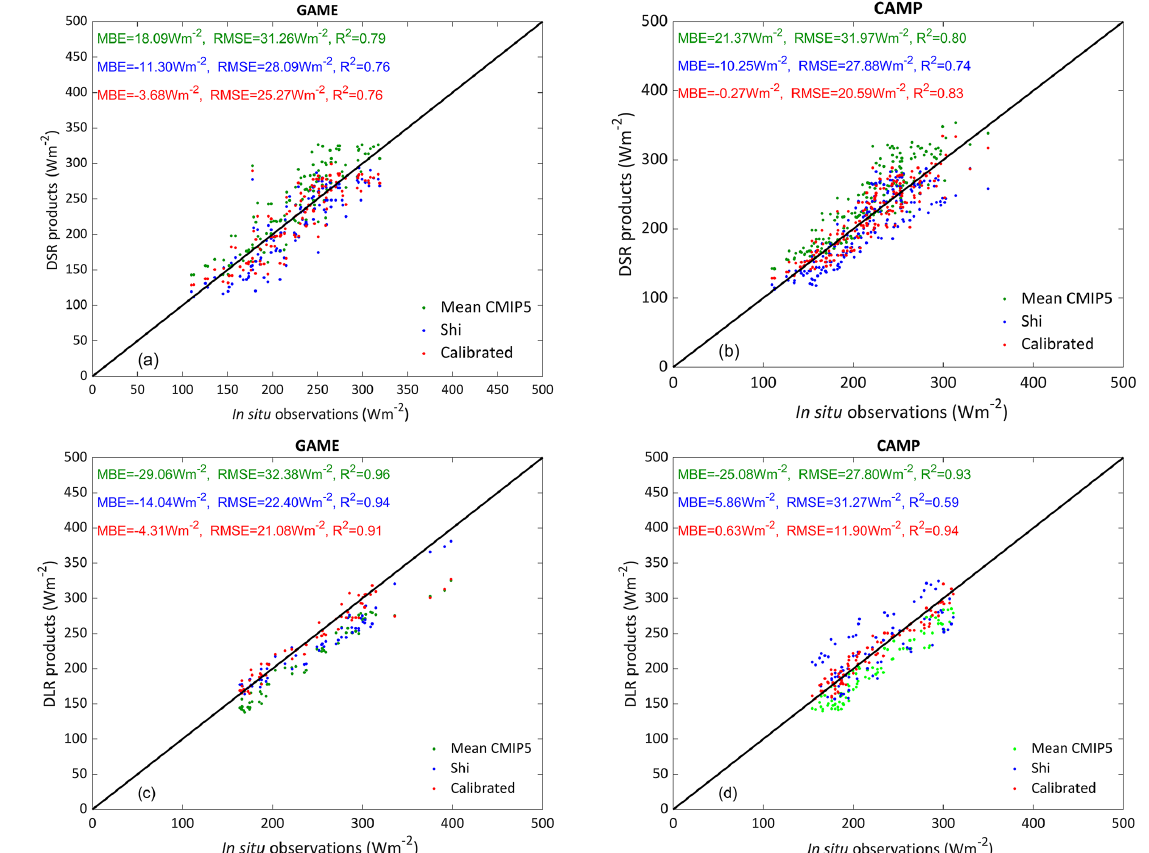
Figure 2. Scatterplot of site validation results from two ground networks: (a, b) DSR and (c, d) DLR.